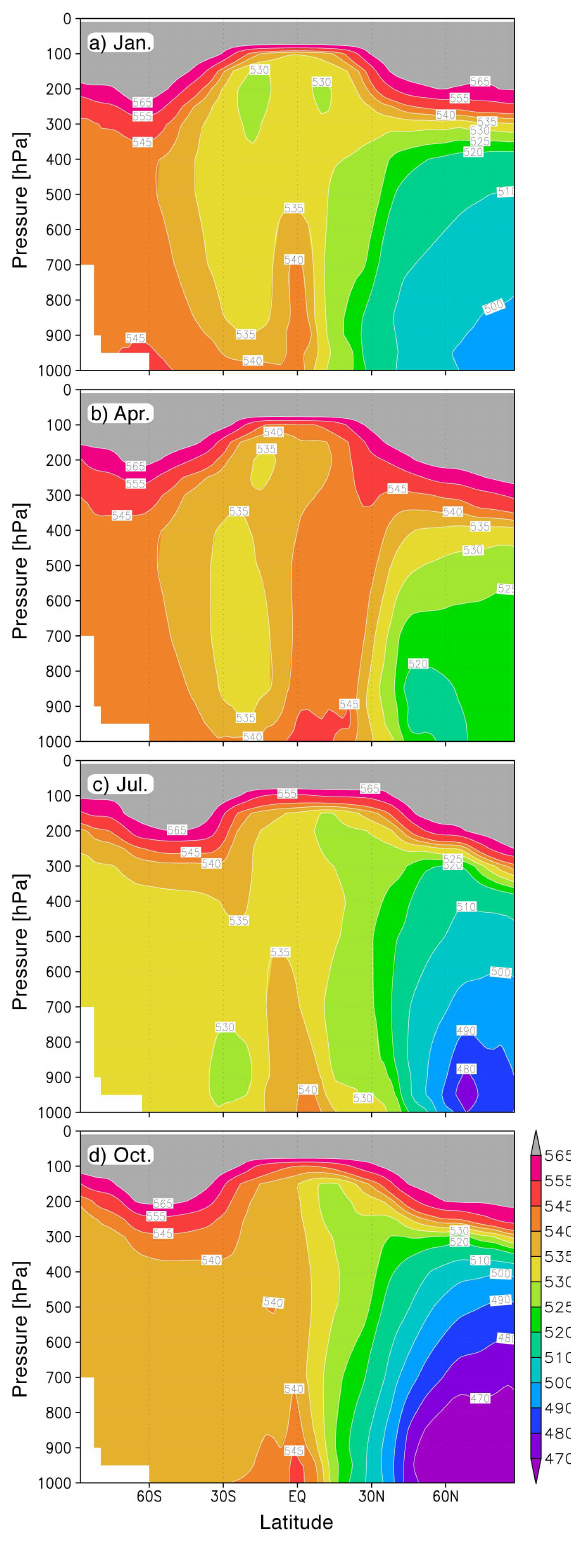
Fig. 7. Latitude-pressure cross-section of zonally averaged H 2 mix- ing ratio (ppb) calculated for January (a) , April (b) , July (c) , Octo- ber (d) . The values are averaged over the period